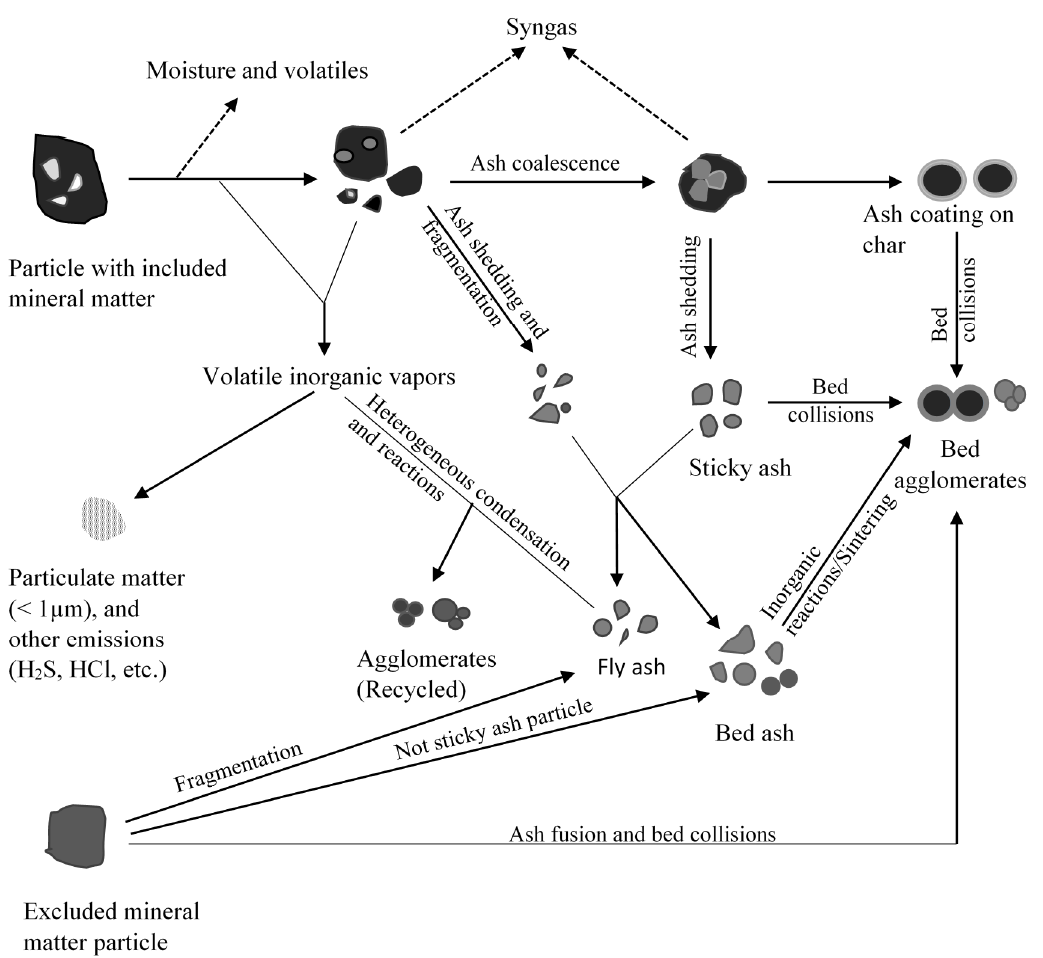
Figure 4. A Schematic summary of mineral matter transformations and formation of agglomerates in a fluidized bed gasifier (Modified after Bartels et al.